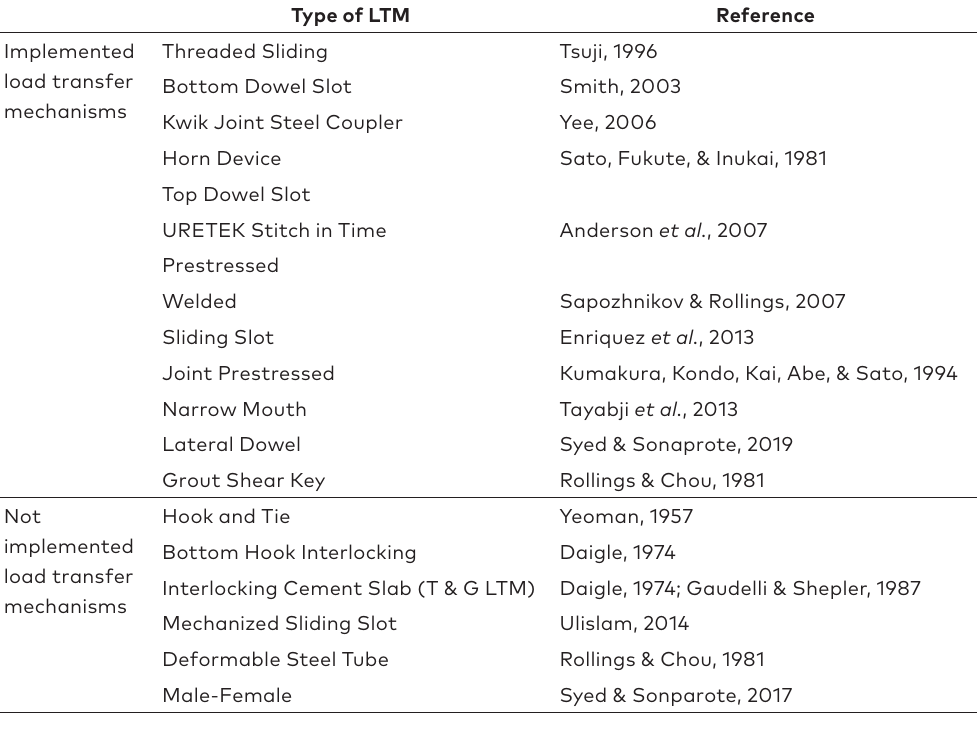
Table 4. Load transfer